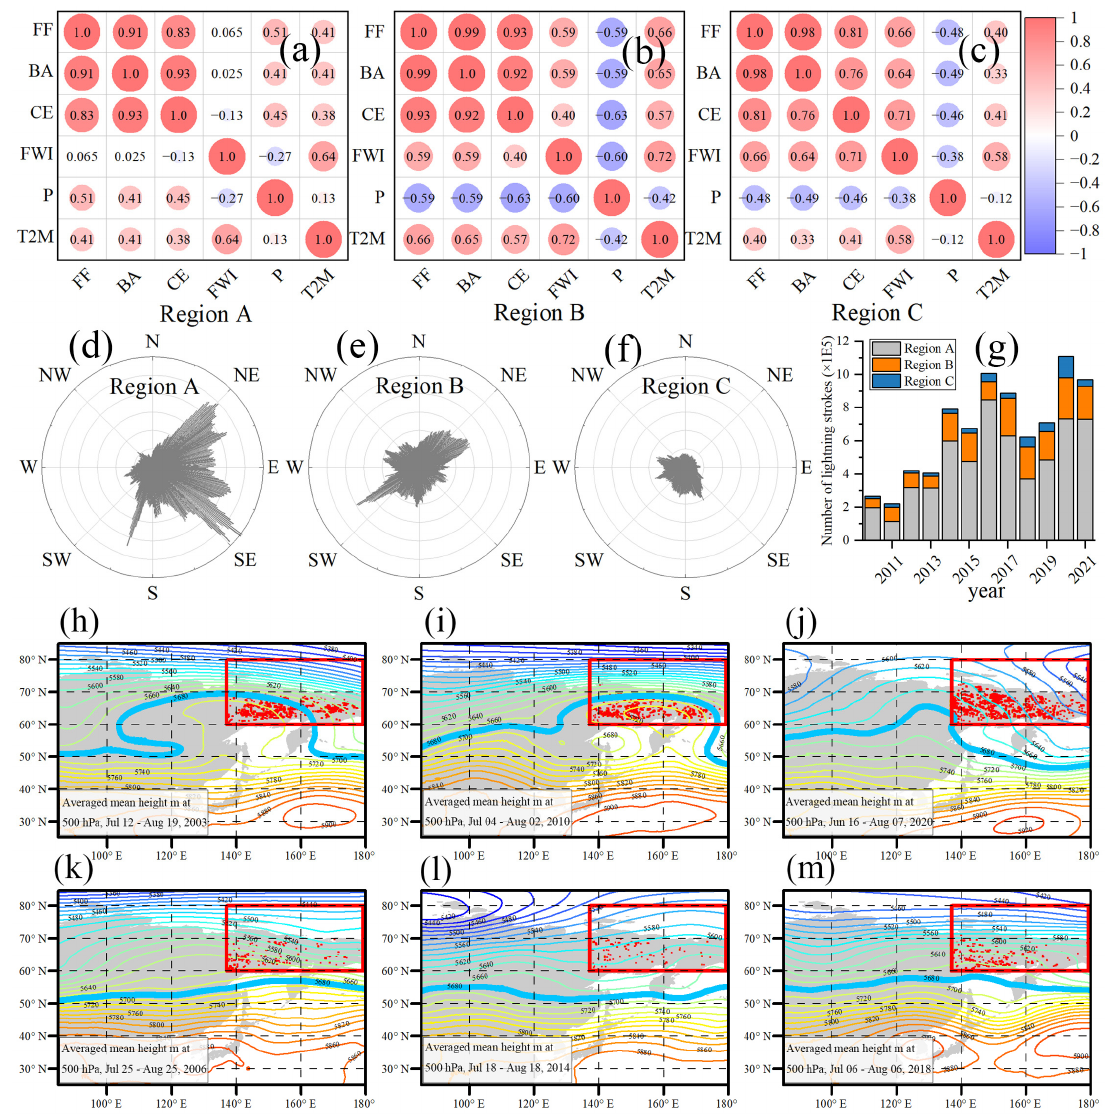
Figure 10. Weather factors affecting patterns of fires. ( a – c ) Correlation coefficient maps among FF (fire frequency, source: MCD14ML), BA (burnt area, source: GlobFire), CE (carbon emissions, source: GFEDv4), FWI (fire weather index, source: ERA5 reanalysis), P (precipitation, source: GPCP monthly mean precipitation rates v2.3), T2M (2 m temperature, source: ERA5-Land) in three regions, A, B and C. ( d – f ) Wind roses for the three regions (June-October). ( g ) The annual number of lightning strokes in the three regions from 2010 to 2021. ( h – m ) Averaged weather maps at upper air (500 hPa) in fire season. The isoline (5680 m) is thickened to highlight the pattern of the westerlies. The red rectangle represents the extent of region C. Red pixels represent fire pixels. ( h – j ) High fire incidence years (2003, 2010, 2020). ( k – m ) Low fire incidence years (2006, 2014,